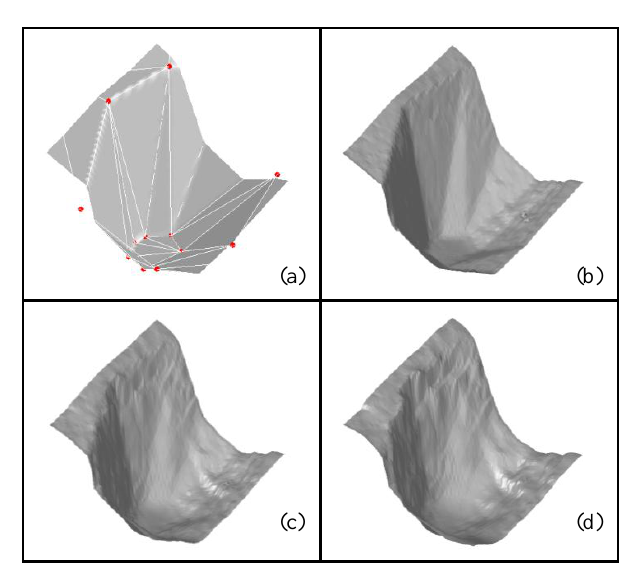
Figure 7. Stages of the surface evolution process, with the initial coarse surface in